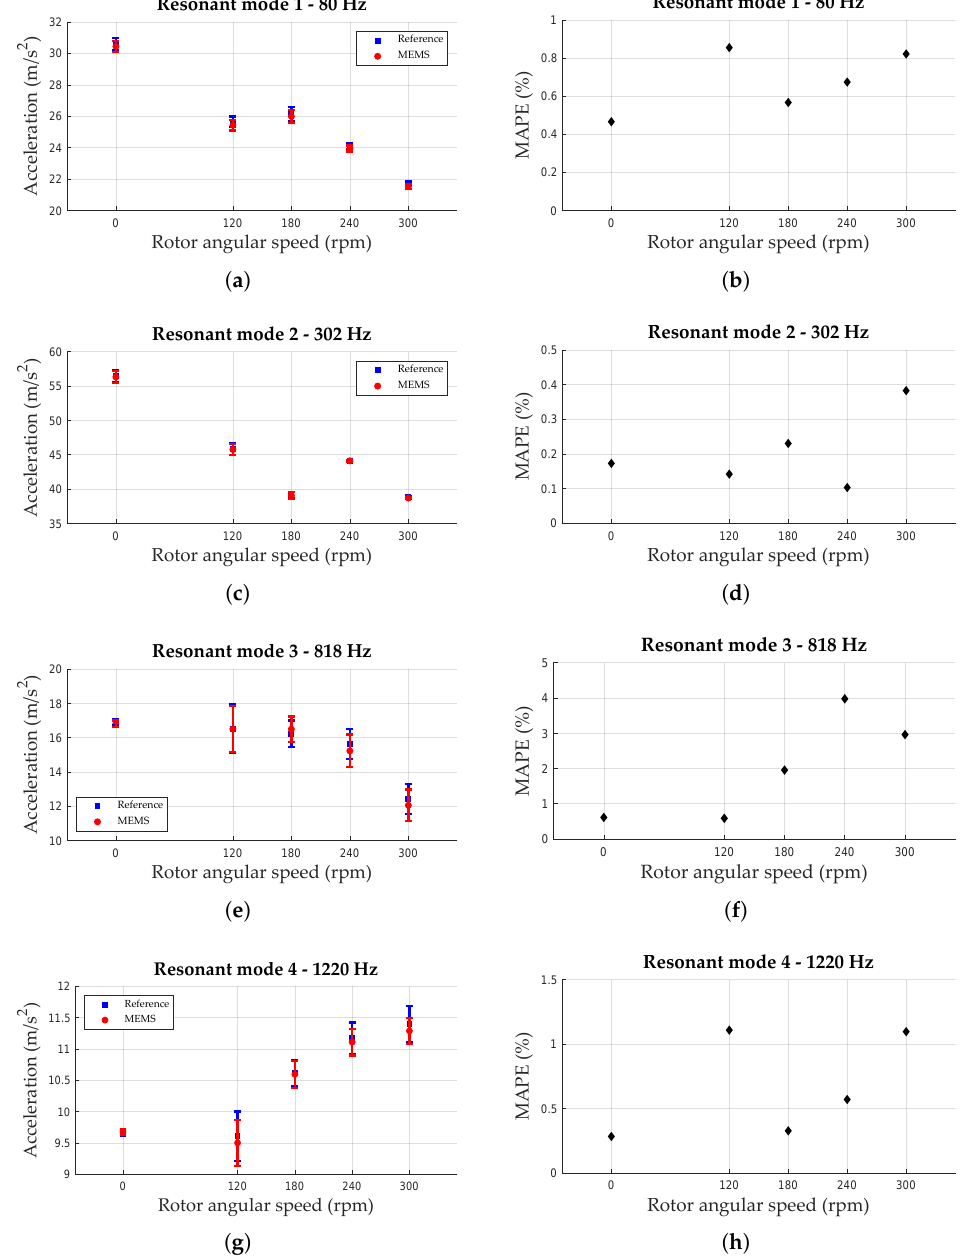
Figure 6. Comparison between wireless and reference acceleration measurement systems within the considered rotor angular speeds. Mean acceleration amplitudes are reported alongside their corresponding error bars representing the standard deviation for: ( a ) the excitation of the first bending mode, ( c ) the excitation of the second mode, ( e ) the excitation of the third mode, and ( g ) excitation of the fourth mode. ( b , d , f , h ) show, respectively, the values of the mean absolute percentage errors (MAPE) for the first four bending modes excitation within the considered rotor speed